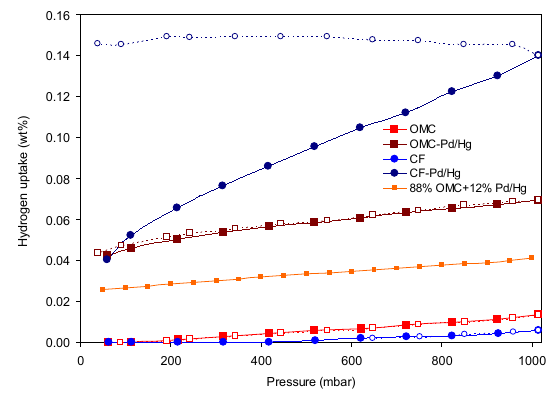
Figure 4. H sorption measurements at 298 K (inset: sorption 2 isotherm of Pd4Hg particles). The 88% OMC+12% Pd/Hg data represent a hypothetical material with no cooperative metal-carbon phenomena (desorption: dotted lines-open